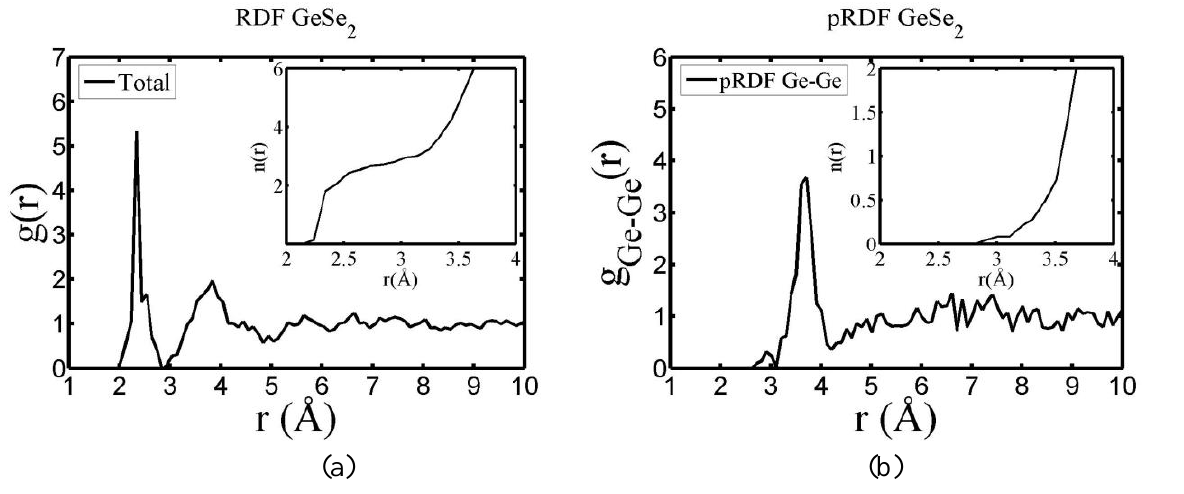
; ( b ) Partial Se–Se RDF for the 2